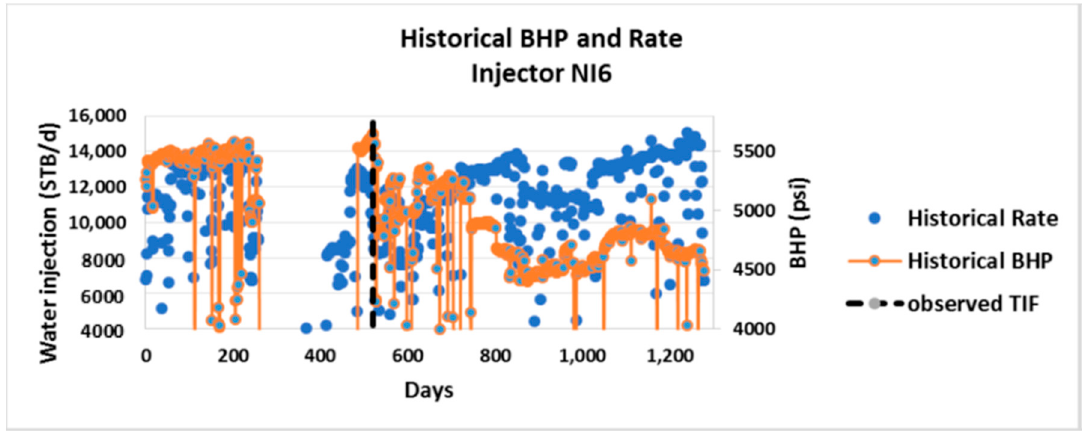
Figure 20. Historical injection rates and bottom hole pressures (BHPs) for Injector NI6.